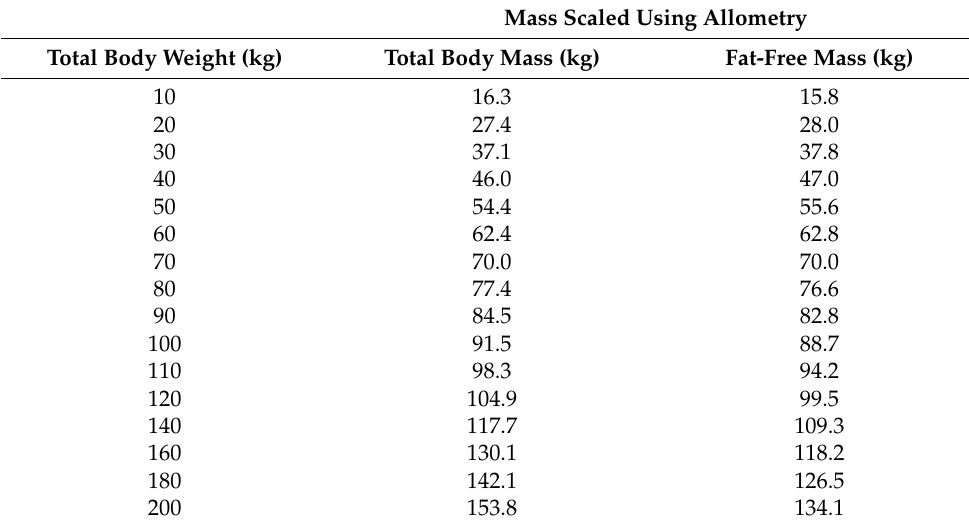
Table 3. Allometric scaling for Fat-Free Mass and Total Body Mass.